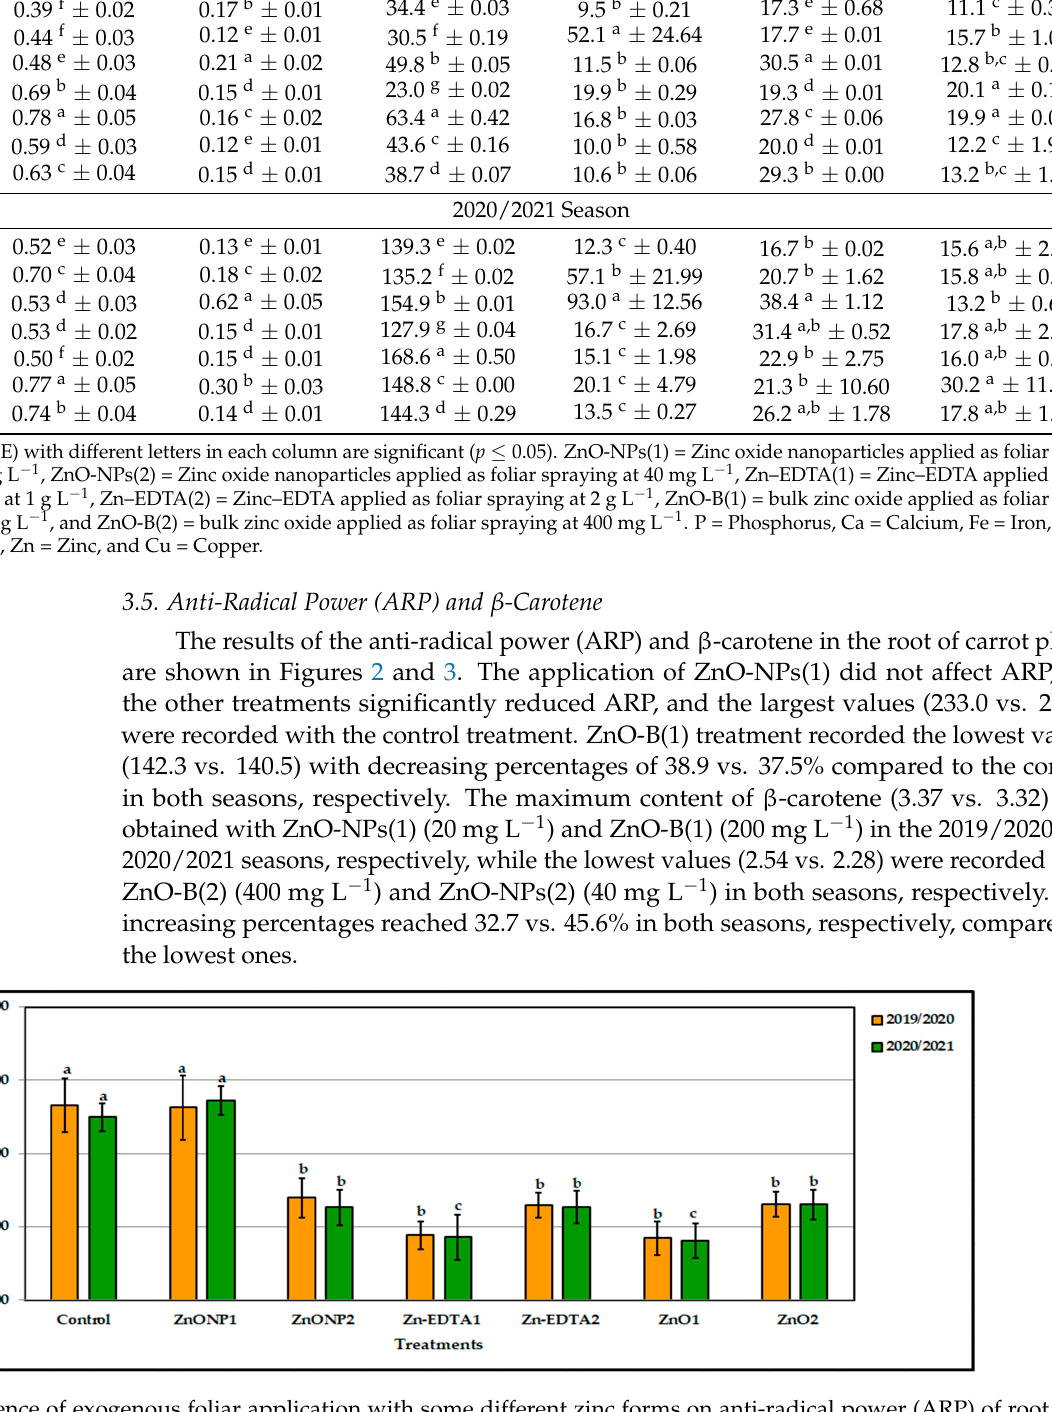
Figure 3. Influence of exogenous foliar application with some different zinc forms on β -carotene ( β -carotene g FW − 1 ) of root carrot grown under zinc-deficit stress in 2019/2020 and 2020/2021 growth seasons. Bars with a different letter indicate significant difference between treatments at p ≤ 0.05. 3.6. Root Yield and Its Components The results regarding the effect of ZnO-NPs, Zn–EDTA, and ZnO-B on the root quality of carrot plants are depicted in Table 7. Table 7. Influence of foliar nourishment with some zinc (Zn) forms on yield and its components of carrot plants grown under Zn deficiency stress in two growth seasons. Treatments